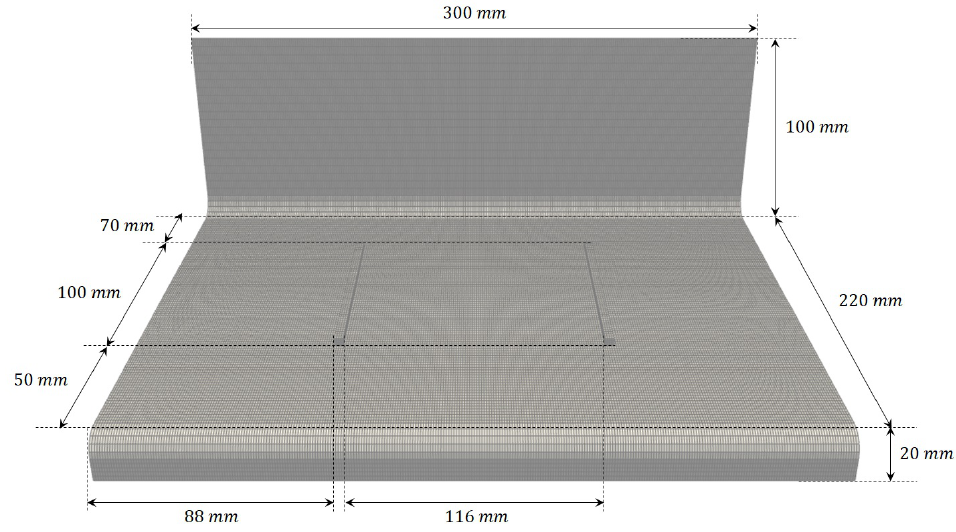
Figure 3. Metallic structure considered in the present case